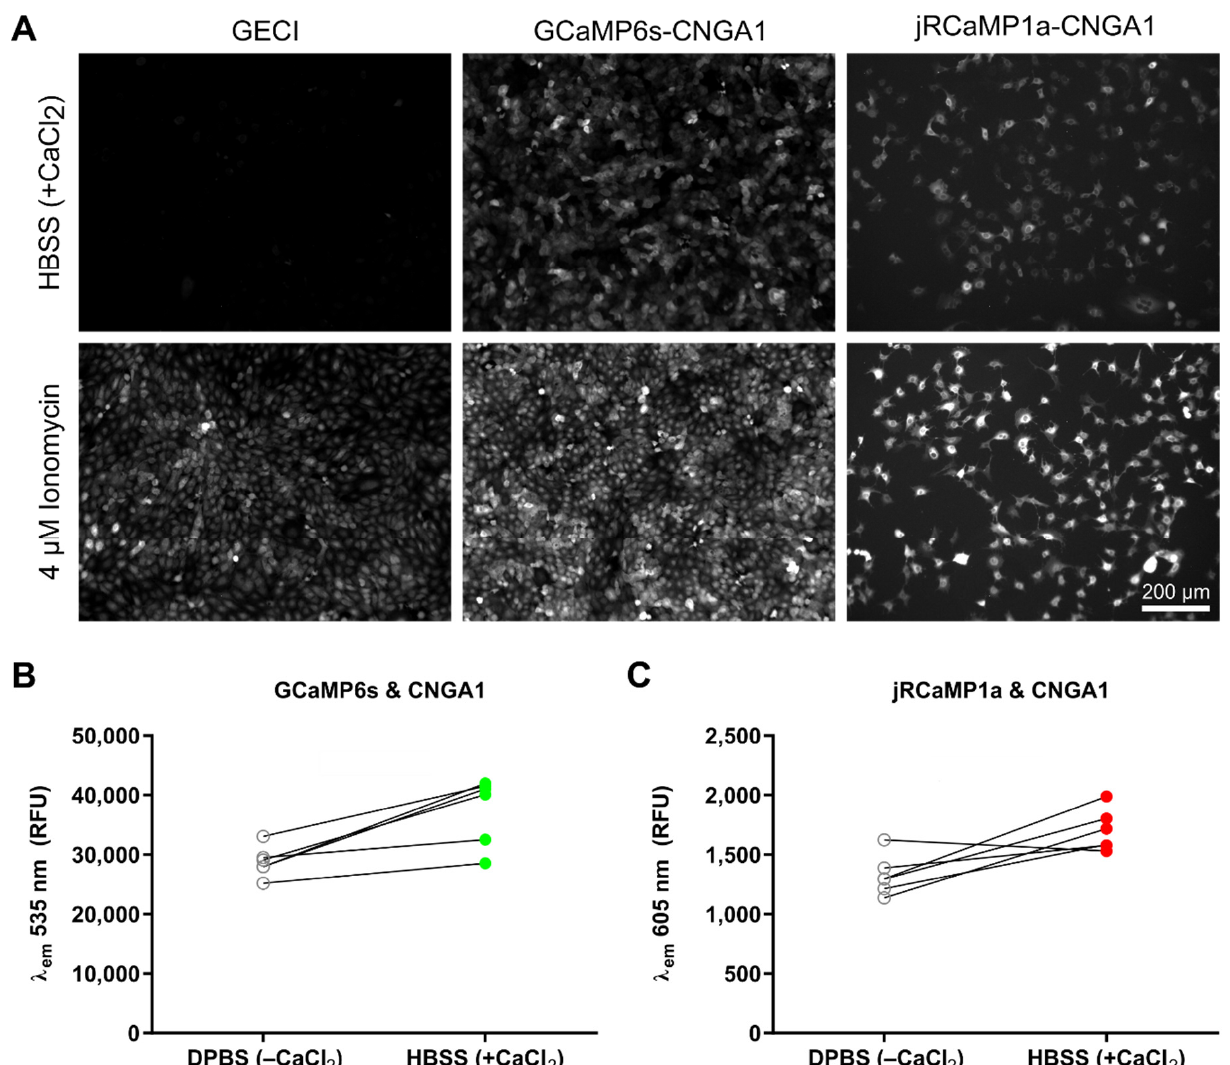
Figure 3. Positive control series with stably integrated CNG channel to confirm that the binary reporter system works in the presence of all three constituent proteins, i.e., RhGC, CNG and GECI. ( A ) Fluorescence images of GECI signal obtained from engineered HeLa cells expressing